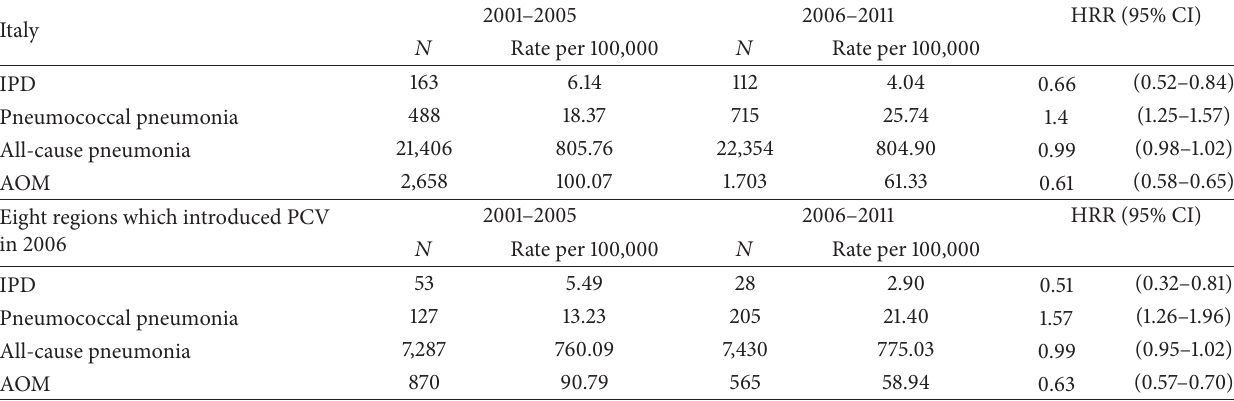
Table 3: Hospitalization rates (per 100,000) and HRRs (95% CIs) for IPD, Streptococcus pneumoniae pneumonia, all-cause pneumonia, and AOM in the pre- and postvaccination period in Italy and in the first eight regions that introduced PCVs in